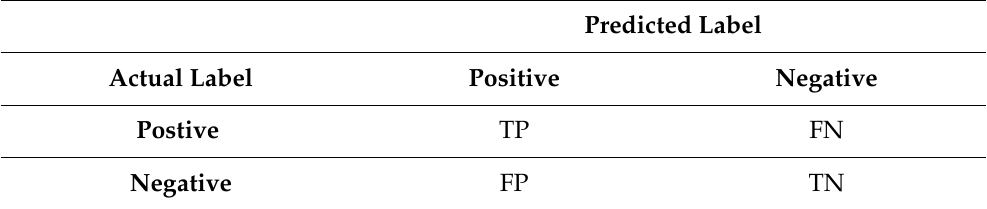
Table 1. The basic formulation of the confusion matrix, where TP represents true positive, FN indicates false negative, false positive is represented by FP, and TN represents true